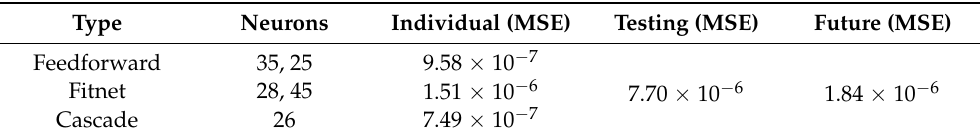
Table 3. Best architecture for